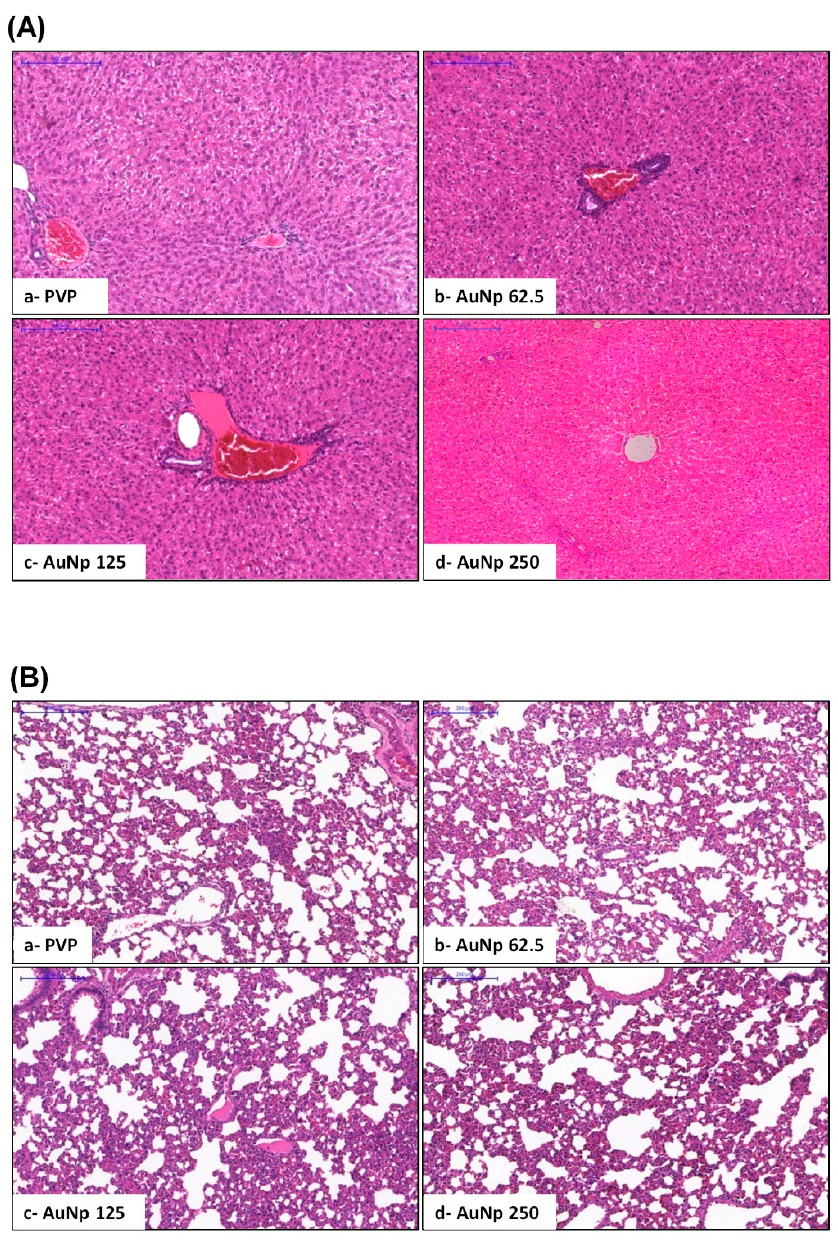
Figure 3. ( A ) Histopathological analysis of the hamster liver. ( B ) Histopathological analysis of the hamster lung. Both organs showed intact tissues with an aspect of normality. PVP group: Animals without oral mucositis ( a ). Groups with OM treated with AuNp 62.5 μ g/kg ( b ); AuNp 125 μ g/kg ( c ); AuNp 250 μ g/kg ( d ).